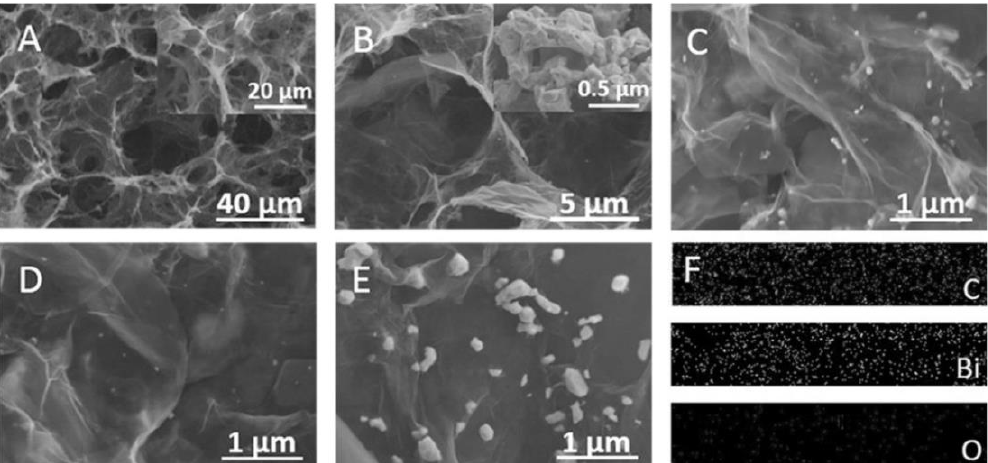
Figure 5. FESEM images of ( A ) 3D graphene framework (GF)/BiNP film, inset: 3D GF film, ( B ) graphene framework of GF/BiNP film, inset: pure BiNPs prepared in a homogenous solution, ( C ) uniformly dispersive BiNPs on graphene surface prepared with 2 mg mL −1 Bi(NO 3 ) 3 , BiNPs on graphene prepared with ( D ) 0.5 mg mL −1 and ( E ) 4 mg mL −1 Bi(NO 3 ) 3 . ( F ) EDX mappings of C, Bi and O element distribution respectively. (Reproduced with permission from [100], Copyright 2017 Elsevier B.V).